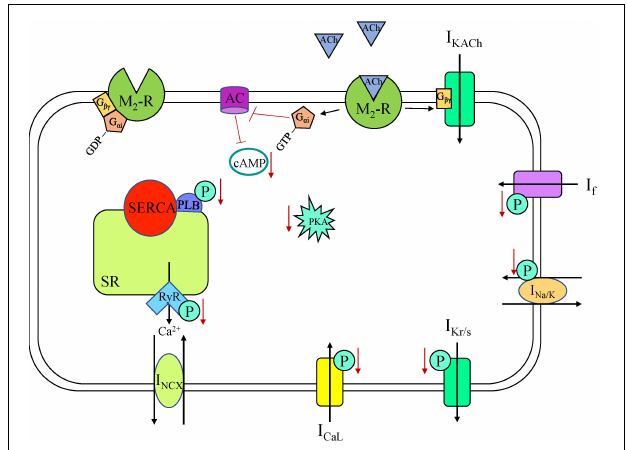
FIGURE 3 | Muscarinic acetylcholine receptor (M 2 -R) signaling cascade in a sinoatrial node myocyte. AC, adenylyl cyclase; ACh, acetylcholine; cAMP, cyclic adenosine monophosphate; I CaL , long-lasting (L-type) Ca 2 + current; I f , “funny” current; I KACh , acetylcholine-activated K + current; I Kr / s , rapid/slow delayed rectifier K + current; I Na / K , Na + -K + ATPase current; I NCX , Na + -Ca 2 + exchanger current; P, phosphorylation; PKA, phosphokinase A; PLB, phospholamban; RyR, ryanodine receptor, SERCA, sarco/endoplasmic reticulum Ca 2 + -ATPase; SR, sarcoplasmic reticulum.